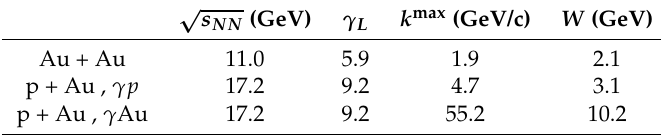
Table 2. Parameters of UPCs Au + Au and p + Au at NICA.